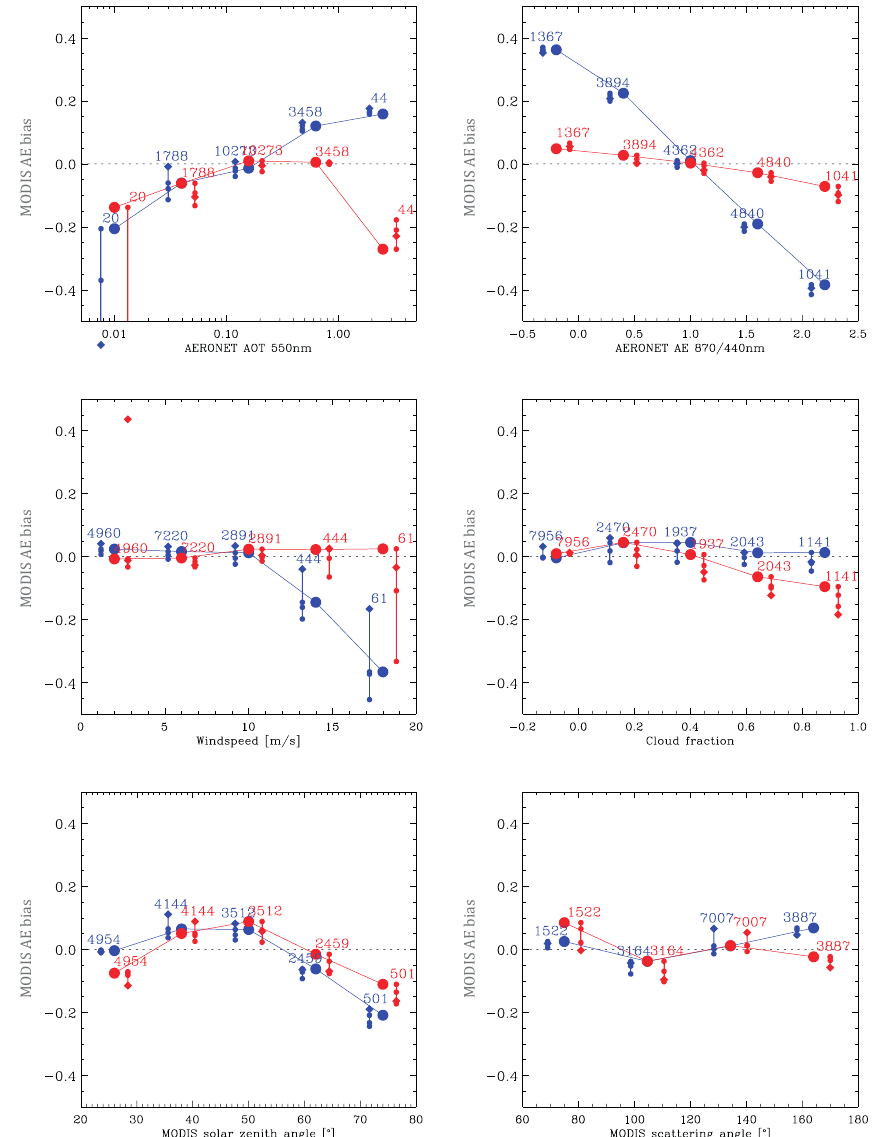
Fig. 14. Biases in Aqua AE as a function of several variables, for both the original (blue) and corrected (red) observations. The numbers in the plot show sample size per bin. The fatter dots, connected by lines, show the biases for the sub-sample that was used to construct the correction algorithm (closest). The dots along the vertical lines show the biases for three sub-samples (closest, random and farthest). The diamond represents the bias for the full